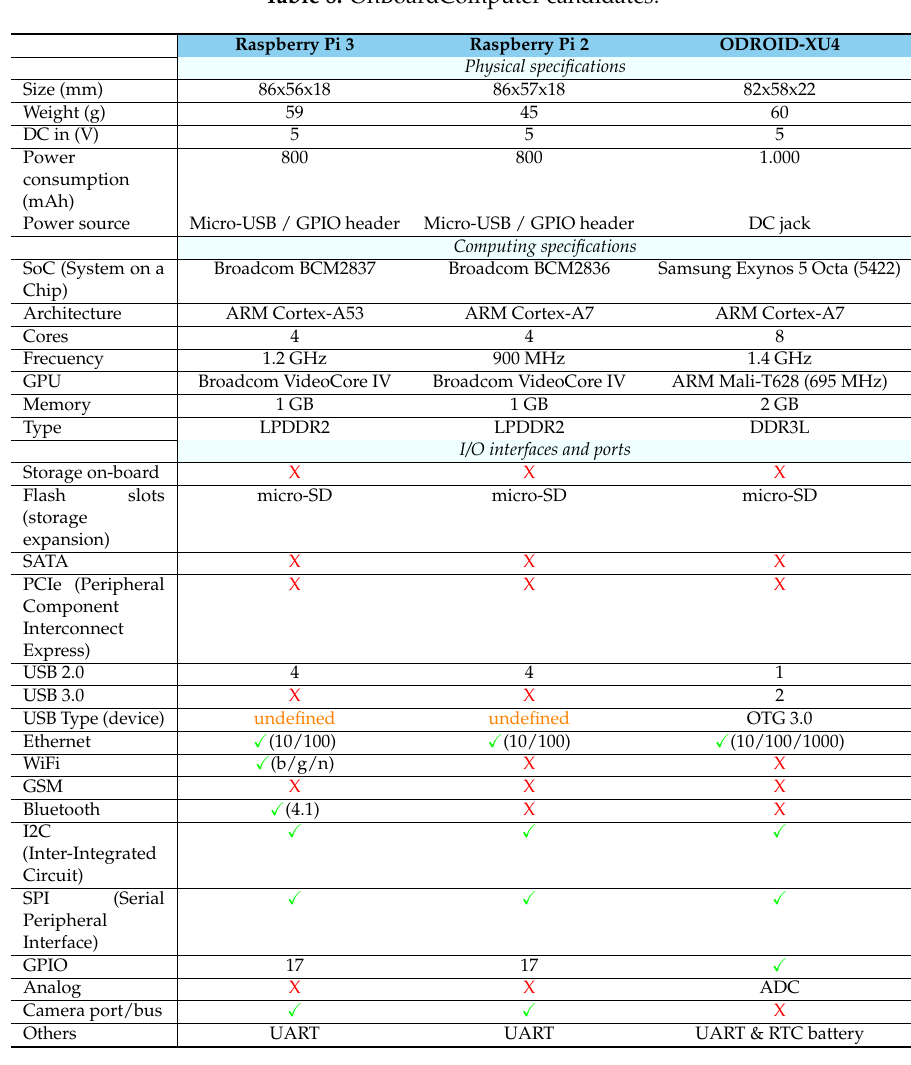
Table 8. OnBoardComputer